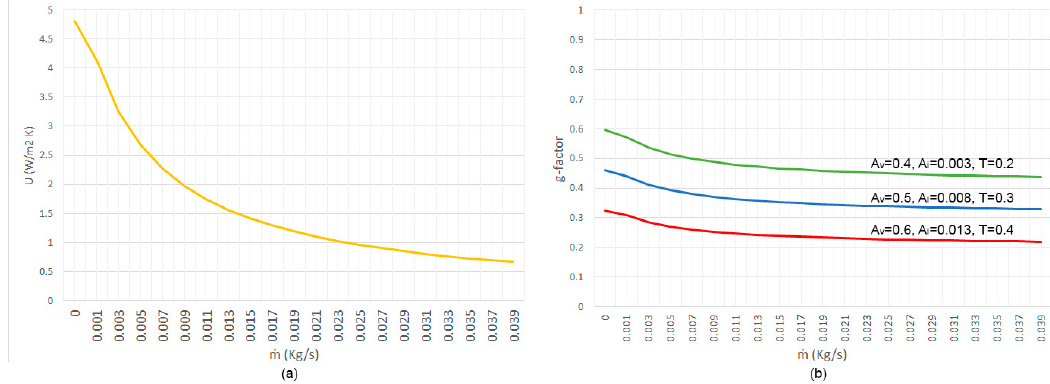
Figure 4. ( a ) U value of WFG depending on the mass flow rate, ṁ . ( b ) g-factor of WFG depending on ff erent glazing the mass flow rate, ṁ , with three different glazing types. the mass flow rate, ˙m , with three di